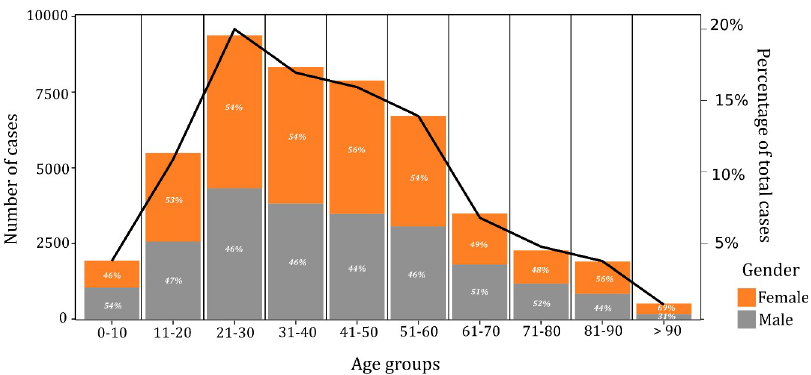
Fig 1. Age and gender distribution of symptomatic COVID-19 cases in the Republic of Ireland, February 29 th – November 30 th 2020 (crude cases and percentage).